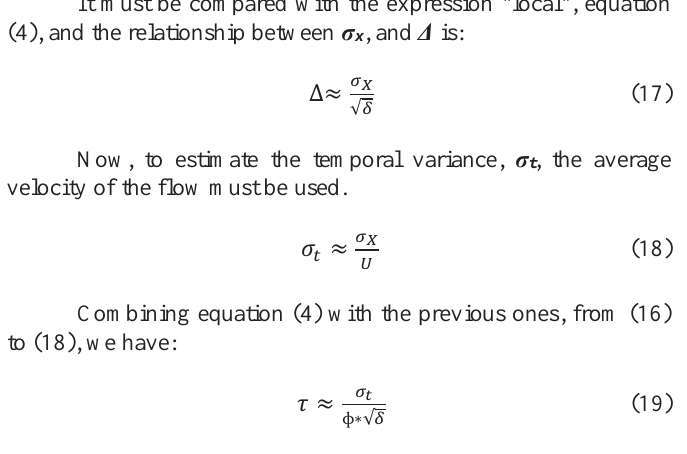
Figure 13: "Complete mix" condition on